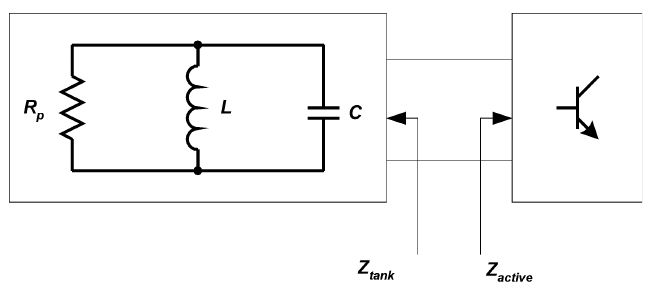
FIGURE 1 General harmonic